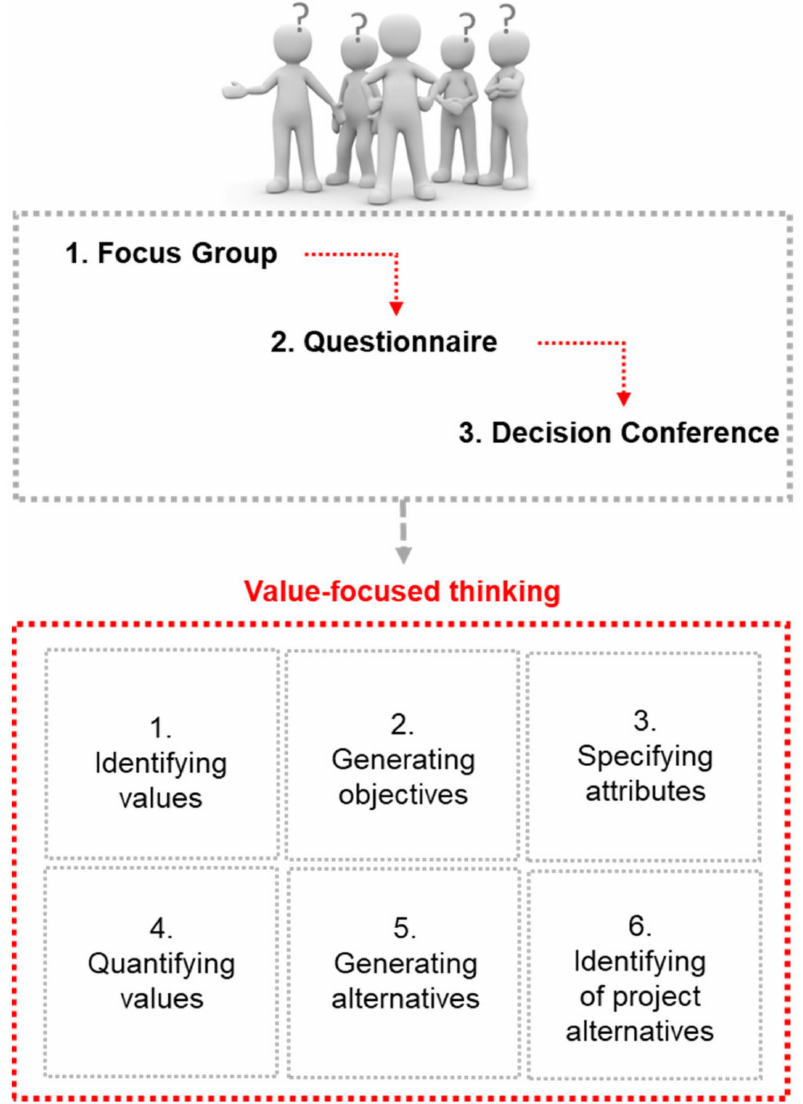
Figure 2. The process flow chart for identifying preference structures (our